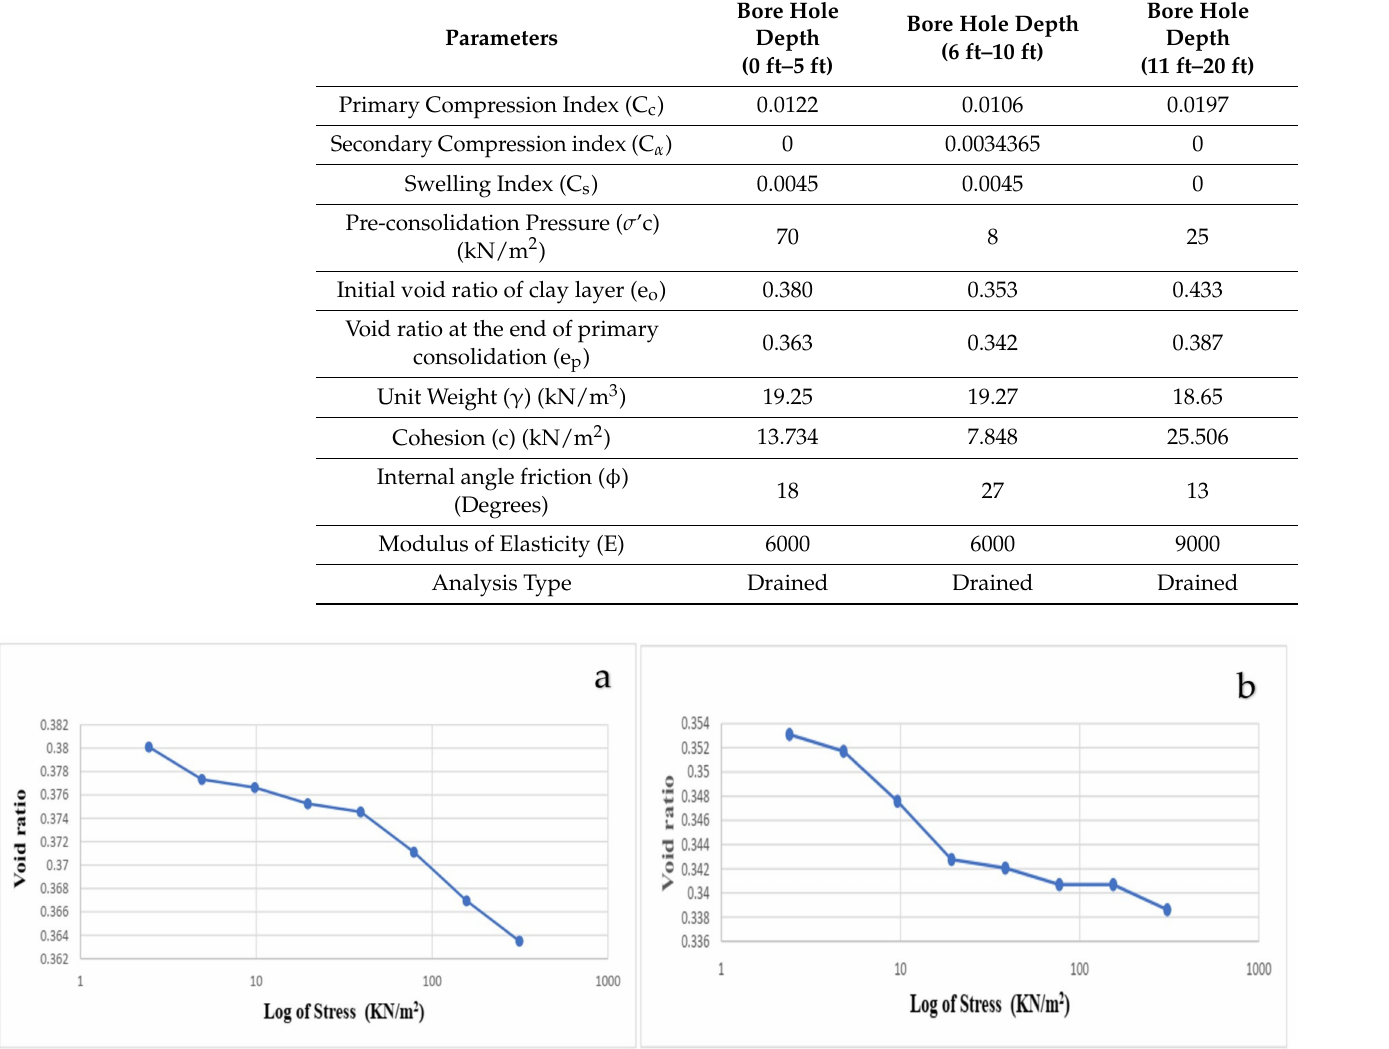
Figure 6. Stress and voids ratio curves: ( a ) 0 to 5 ft and ( b ) 6 to 10 ft.